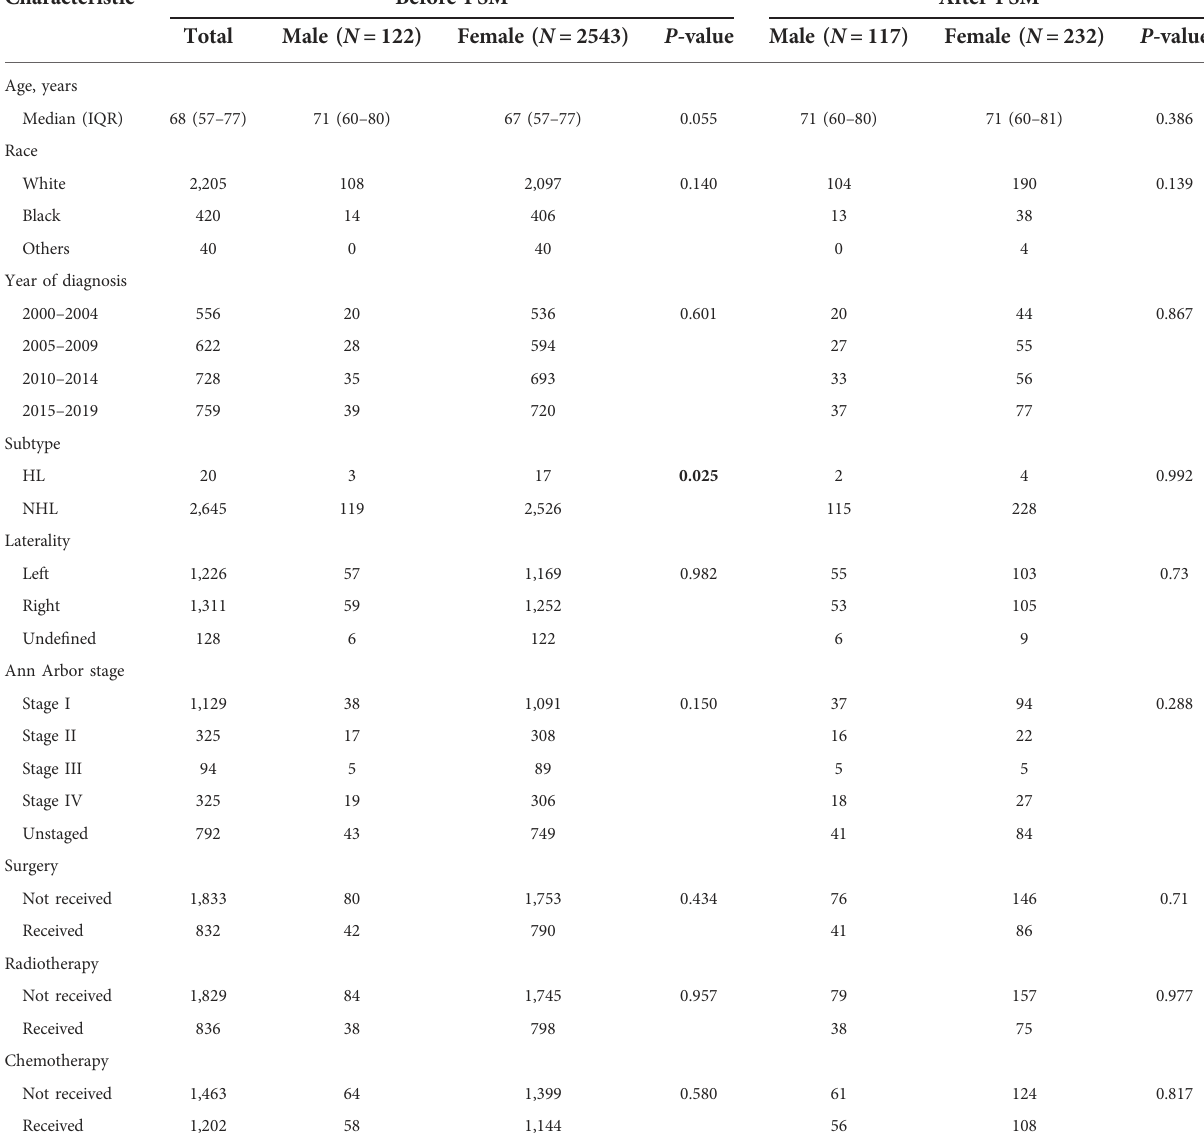
TABLE 1 Clinical demographics among male and female patients with primary breast lymphoma. Characteristic Before